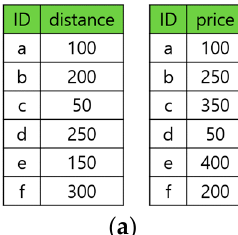
Figure 2. ( a ) Two tables GStat_D and GStat_P; and ( b ) skyline join query in SQL.